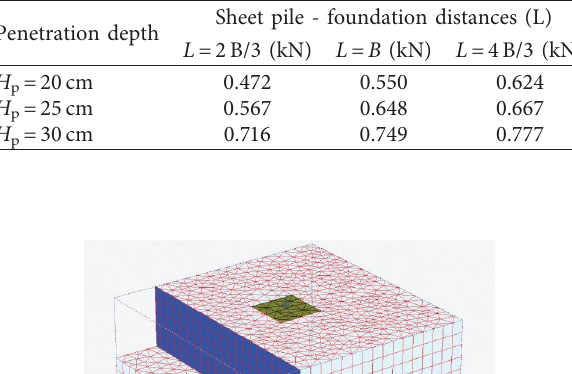
Table 6: Maximum q ult obtained from model experiments. Penetration depth